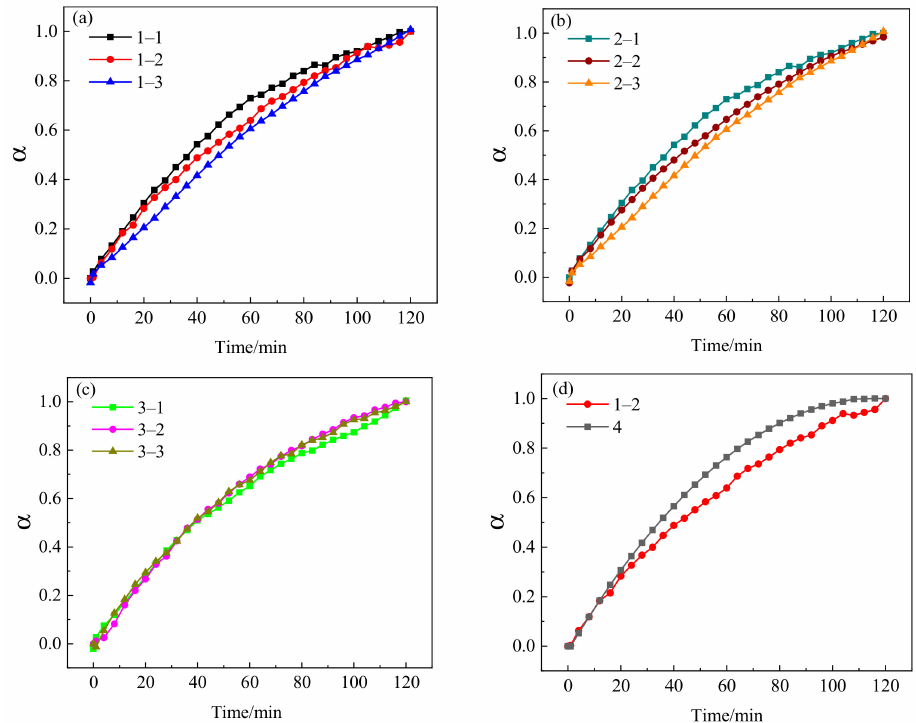
Figure 3. Mass-loss curves of sinter in experiments. ( a ) First group experiment; ( b ) second group experiment; ( c ) third group experiment; ( d ) fourth group